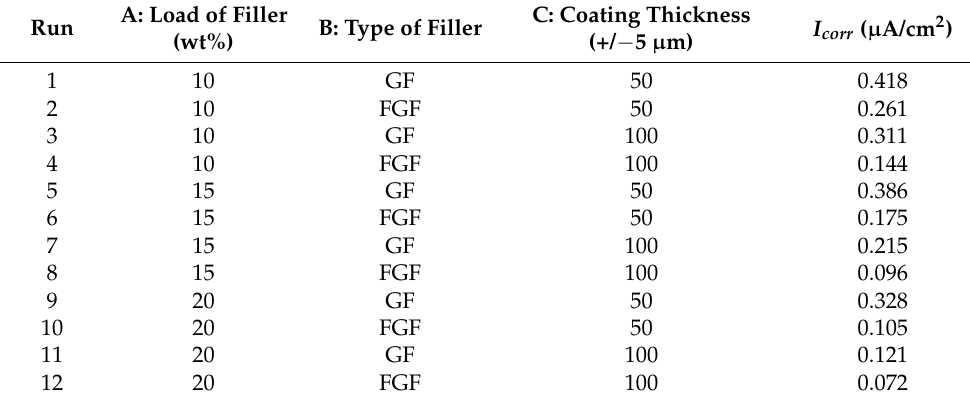
Table 1. Synthesis parameters for E/GF and E/FGF composite